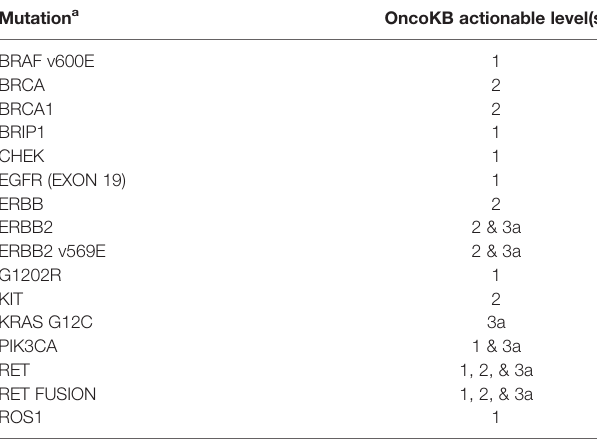
TABLE 6 | Mutations identi fi ed with OncoKB actionable level 1, 2 or 3. Mutation